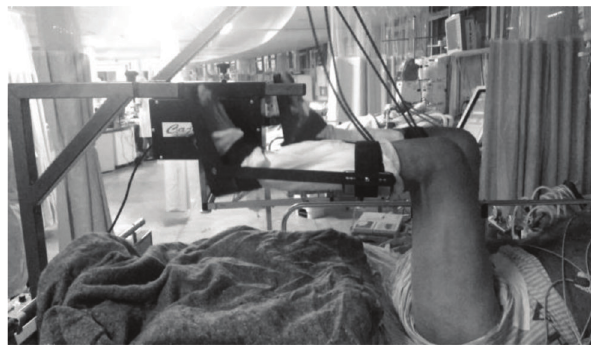
Figure 1 - Illustration of passive cycle ergometer application on lower limbs in critical patients under mechanical